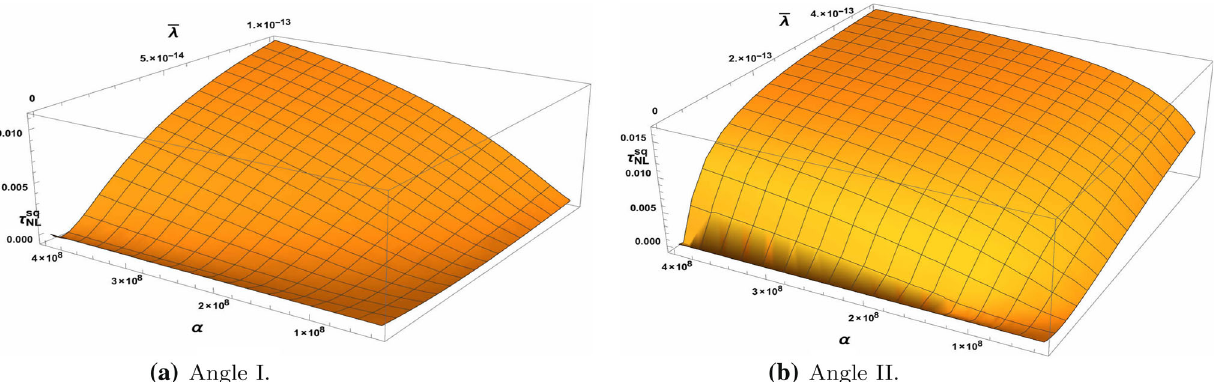
Fig. 30 Representative diagram for equilateral non-Gaussian three point amplitude vs. product of the parameters α ¯ λ in four different regions for = 50 ( red ), N = 60 ( blue ) and N = 70 ( green ) N cmb cmb cmb